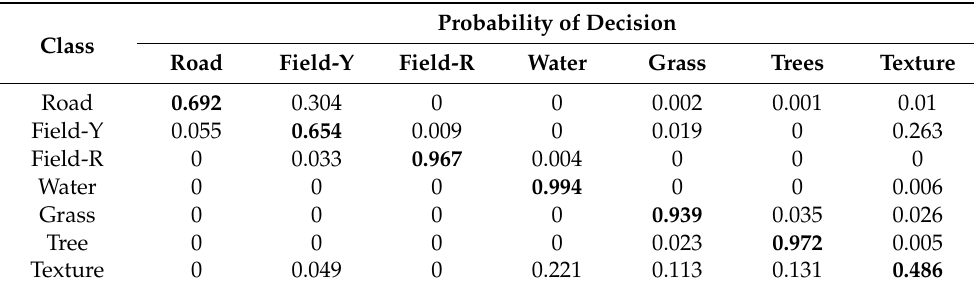
Confusion matrix for compressed image classified by NN trained for this image (PSNR-HVS-M = 30